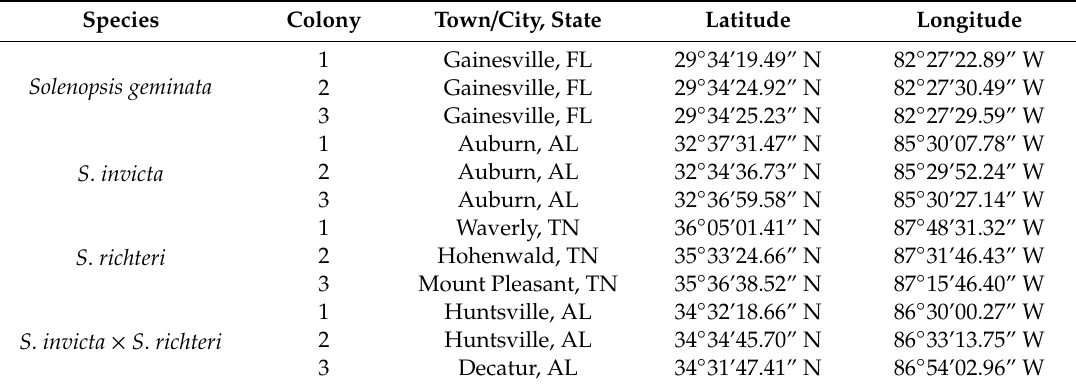
Table 1. Collection locations of S . invicta , S . richteri , S . invicta × S . richteri, and S . geminata fire ants in the USA. Species Colony Town / City, State Latitude Longitude 1 Gainesville, FL 29 ◦ 34’19.49” N 82 ◦ 27’22.89” Solenopsis geminata